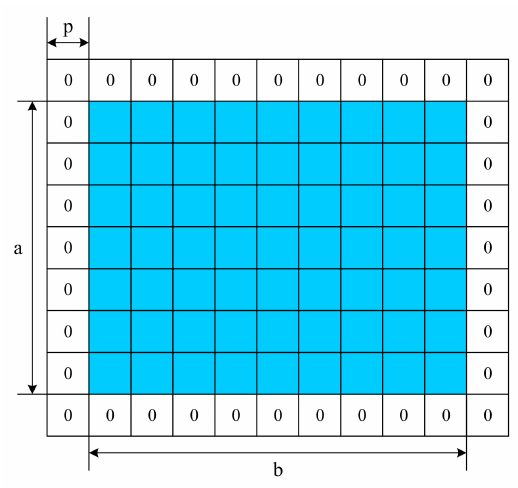
Figure 8. Padding diagrammatic